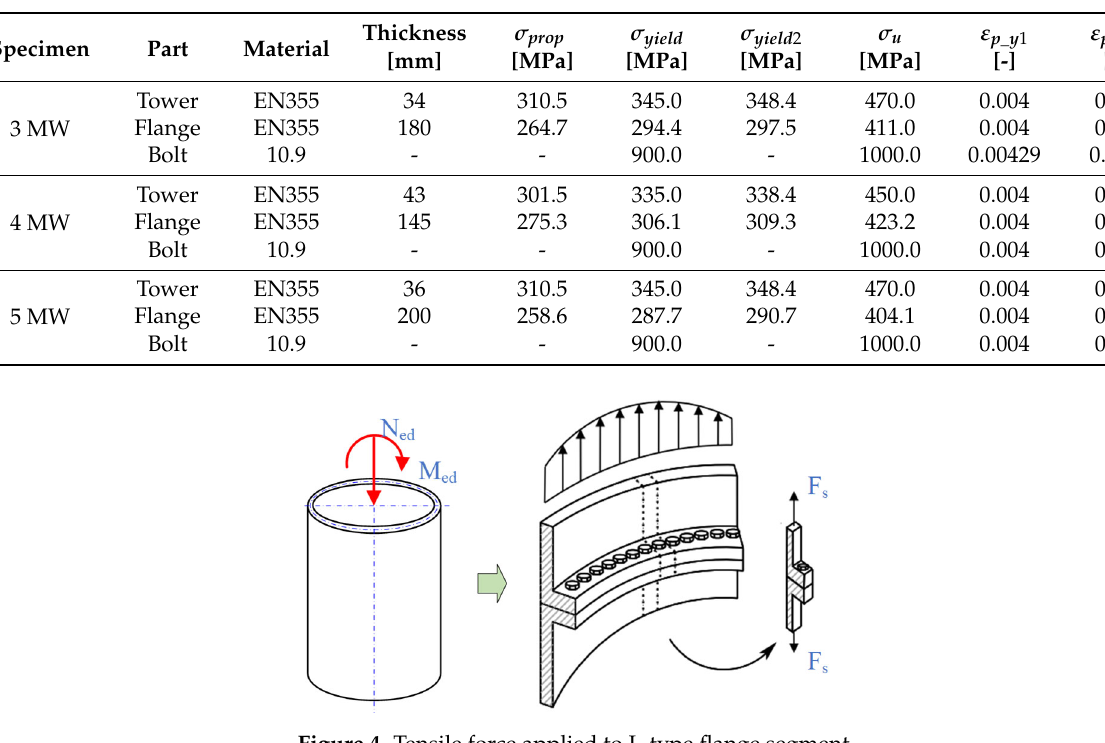
Figure 4. Tensile force applied to L-type flange segment. Table 3. Tensile force at the flange